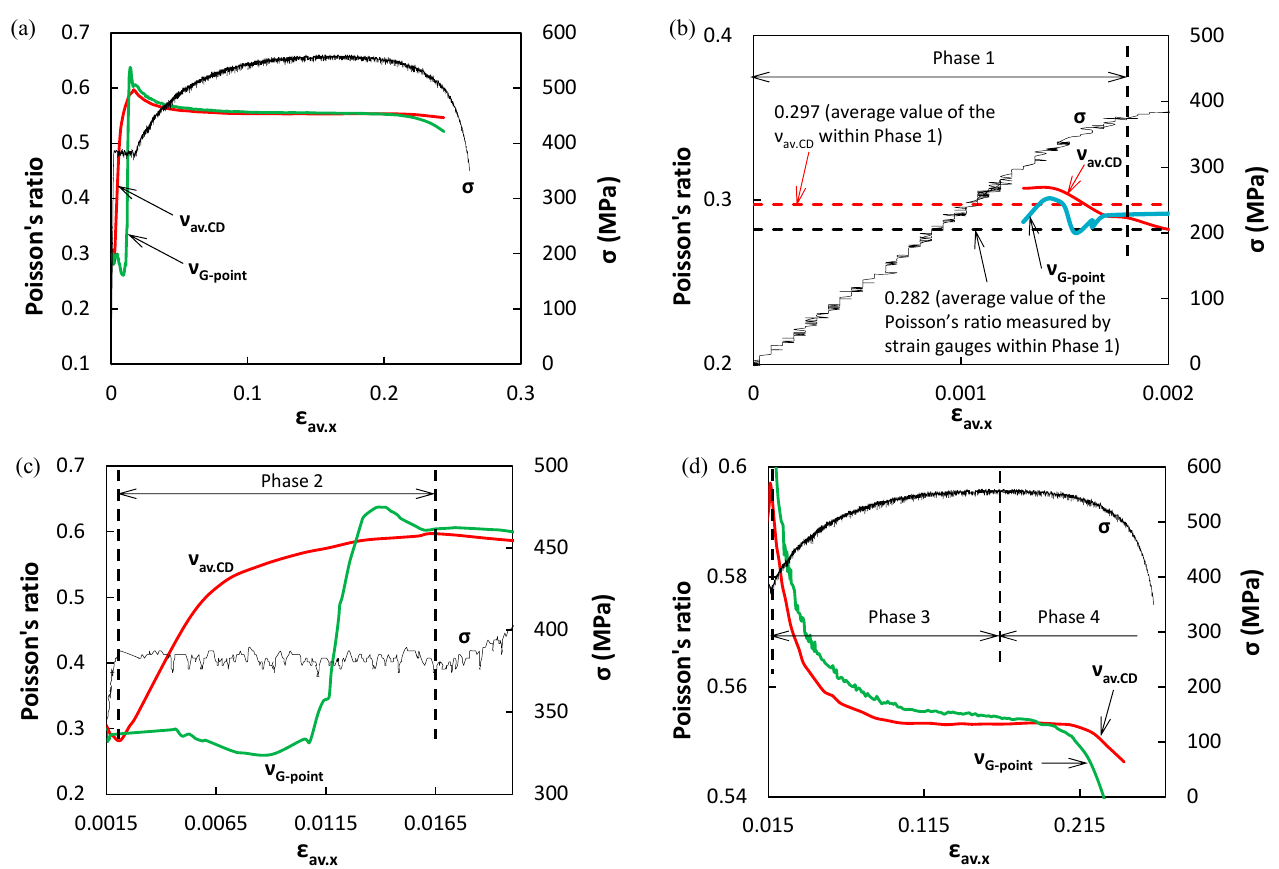
Figure 7. ( a ) The evolution of the average Poisson’s ratio over the CD line ( ν av . CD ) and the local Poisson’s ratio at point G, as shown in Figure 3a ( ν G-point ), in the tension process (from Phase 1 to Phase 4). The tension process is expressed by the stress–strain curve ( σ versus ε av.x ). ( b ) The enlargement of ( a ) within Phase 1. ( c ) The enlargement of ( a ) within Phase 2. ( d ) The enlargement of ( a ) within Phases 3 and 4.